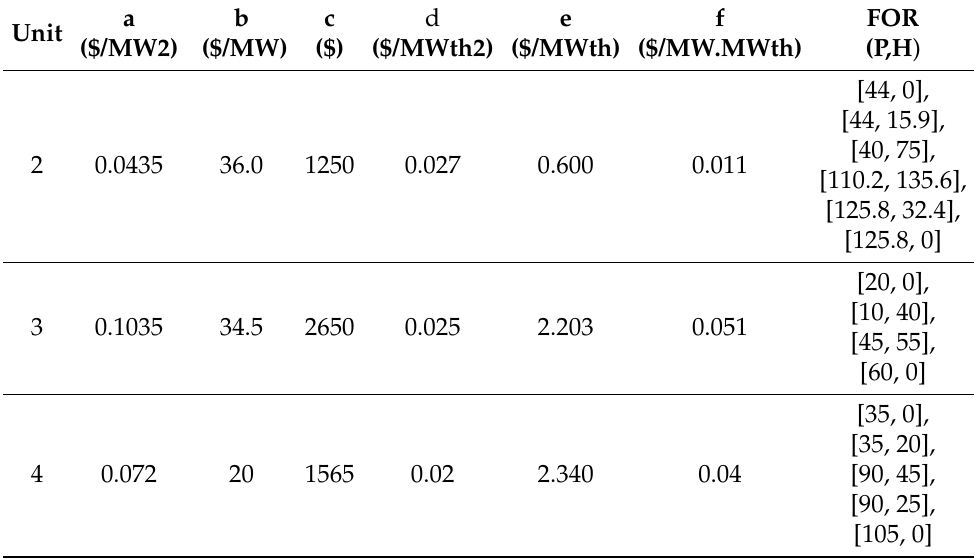
Table A5. Cogeneration unit data for Case Study 2.